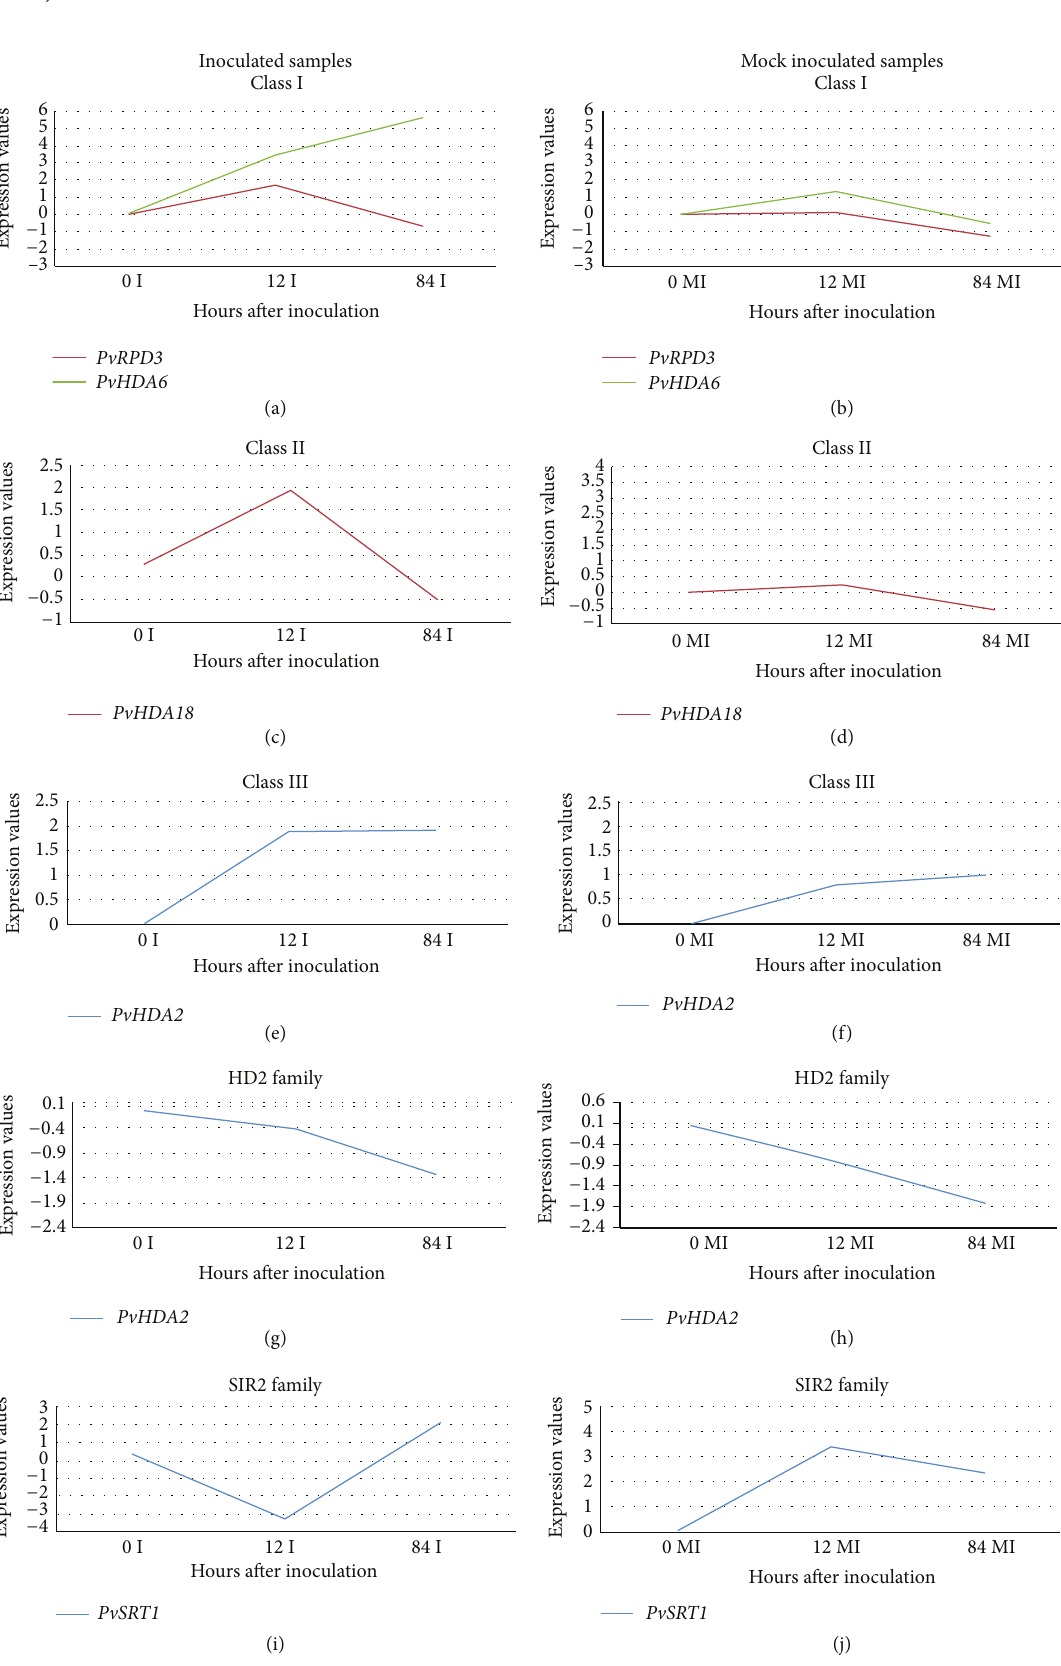
Figure 5: qRT-PCR analysis of HDAC genes. Figures on the left-hand side are from inoculated samples, while figures on the right-hand side are from mock inoculated samples. Sampling time points are shown in 𝑥 -axis and ΔΔ CT values are shown in 𝑦 -axis. Sierra 0 hai mock inoculated samples and the endogenous gene TC362 were used for calculating expression